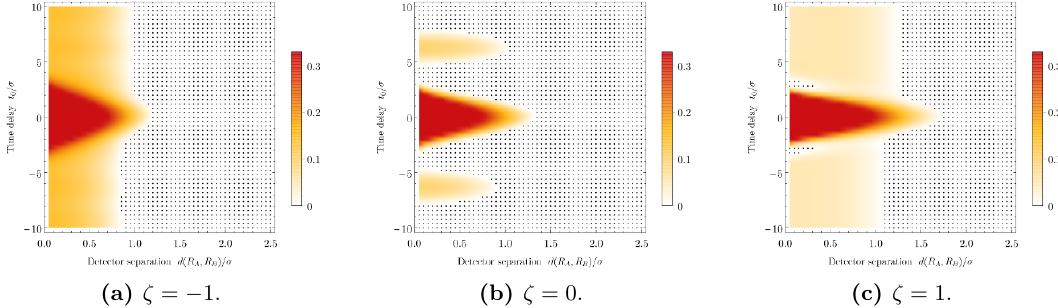
Figure 12 . The concurrence, C = ~ (cid:21) 2 associated with the state (cid:26) AB describing two static detectors is plotted as a function of their proper separation d ( R A ; R B ) =(cid:27) and the relative time delay in their switching functions t 0 =(cid:27) for all boundary conditions (cid:16) = f(cid:0) 1 ; 0 ; 1 g and an AdS length of ‘=(cid:27) = 1. A negative t 0 means that detector B switches before detector A . Detector A is located at the origin, and the energy gap of the detectors is (cid:10) (cid:27) = 1 = 10. The area (cid:12)lled with black dots represents the region where the concurrence vanishes and thus no entanglement harvesting is possible.